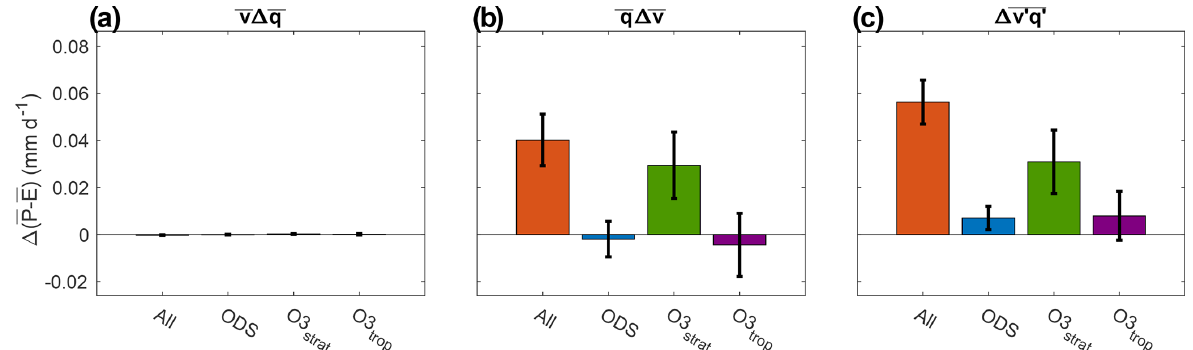
Figure 5. The contributions to the increase in DJF Antarctic P − E , (cid:49) (cid:0) P − E (cid:1) , arising from changes in (a) mean moisture ( v(cid:49)q ), (b) mean meridional circulation ( q(cid:49)v ) and (c) eddy moisture flux ( (cid:49)v (cid:48) q (cid:48) ). Red bars show the response in the full forcing ensemble mean. The blue, green and purple bars show the contributions of ODSs, stratospheric ozone (O3 strat ) and tropospheric ozone (O3 trop ) to the P − E response, respectively. Error bars represent the 95% confidence interval.